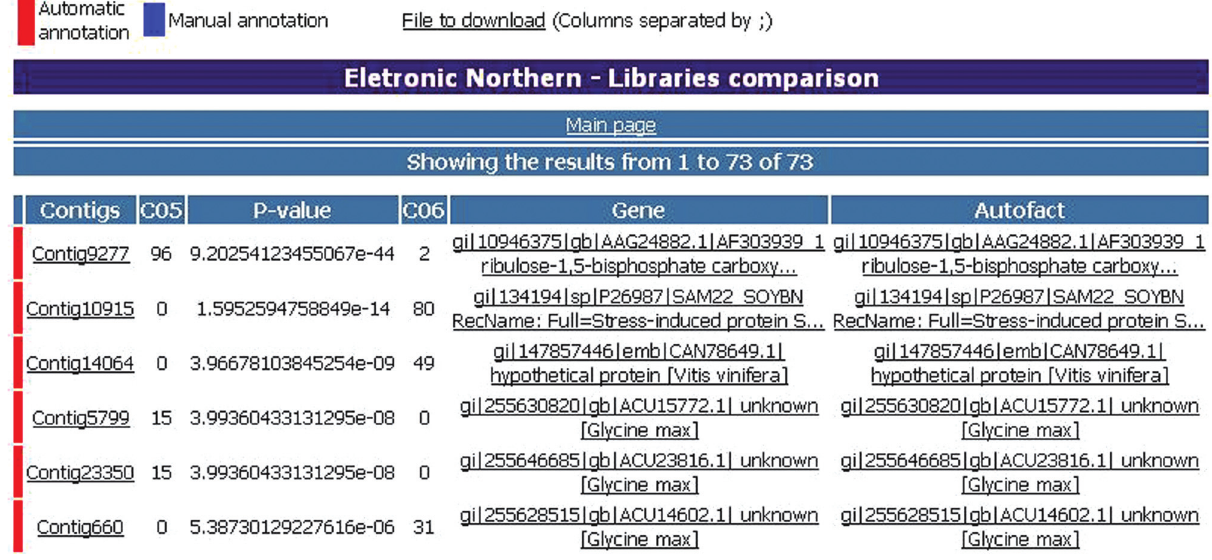
Figure 2 - Electronic northern interface. With this tool it is possible to infer gene expression using an assembly of ESTs. A statistical test (p-value) is per- formed in real time when comparing two libraries. The description of the libraries and tissue ESTs were obtained from a GenBank sequences file using a